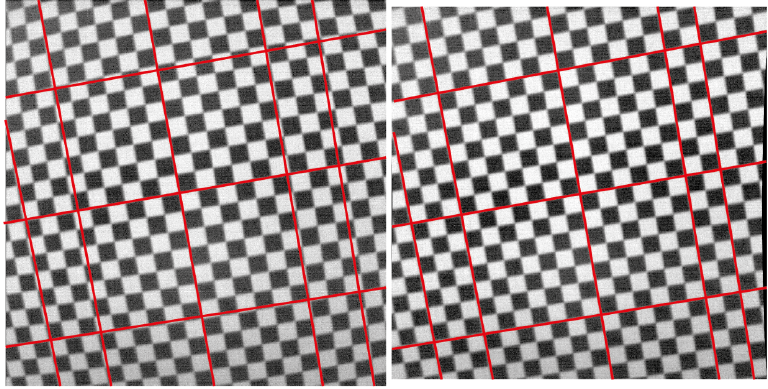
Figure 3. Rikola image of checkerboard pattern before ( left ) and after ( right ) lens distortion correction (Section 5.2). Red lines added for clarity.